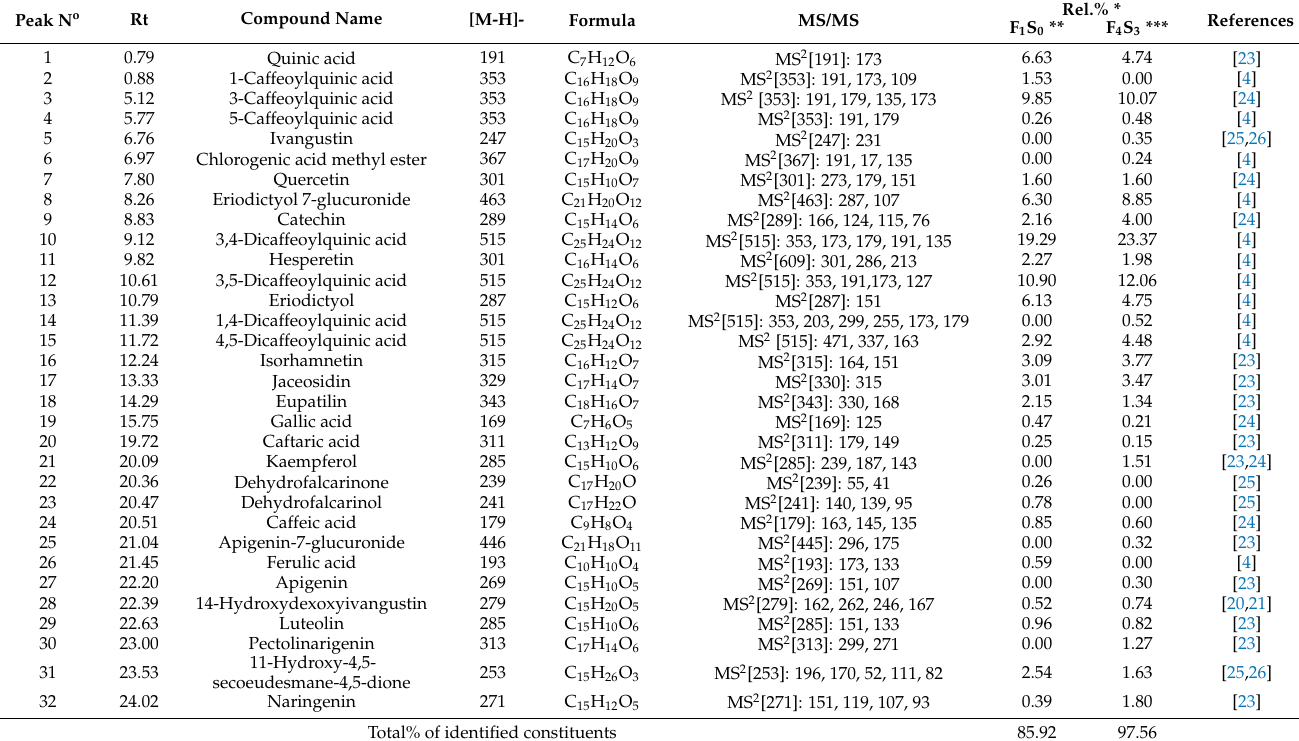
Table 2. UPLC-ESI-MS/MS in negative ion ionization mode of F 1 S 0 and F 4 S 3 ethanol